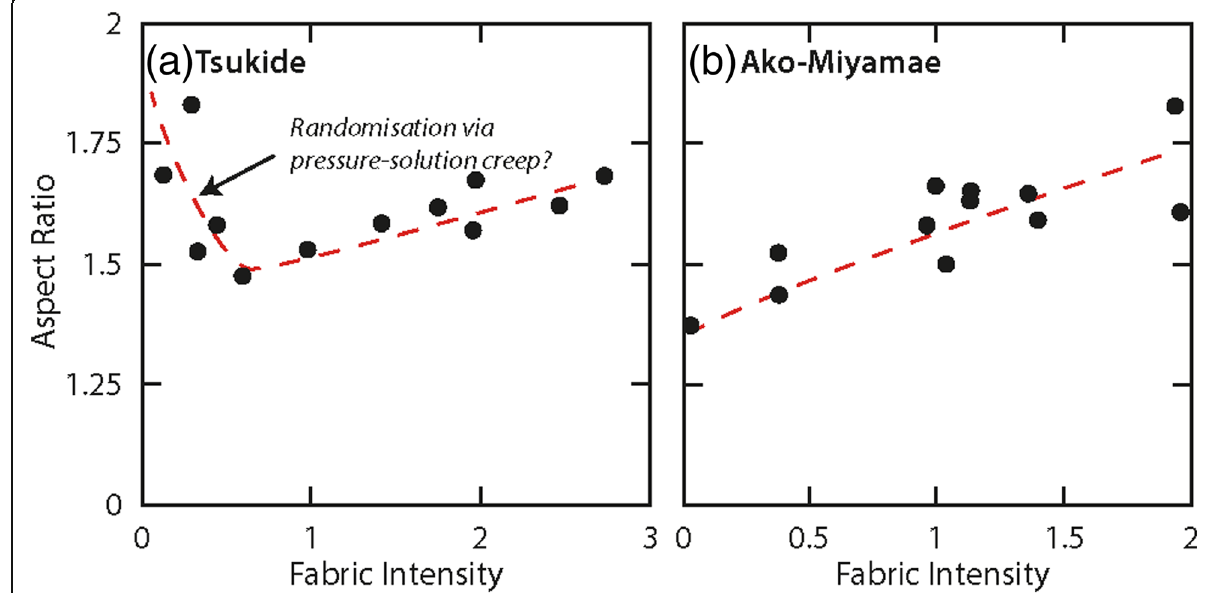
Fig. 13 Intensity of quartz c -axis fabrics vs. mean aspect ratio for recrystallised quartz grains for the Tsukide ( a ) and Ako-Miyamae ( b ) areas. Samples displaying low fabric intensity and elongate grains in ( a ) may have deformed via pressure-solution